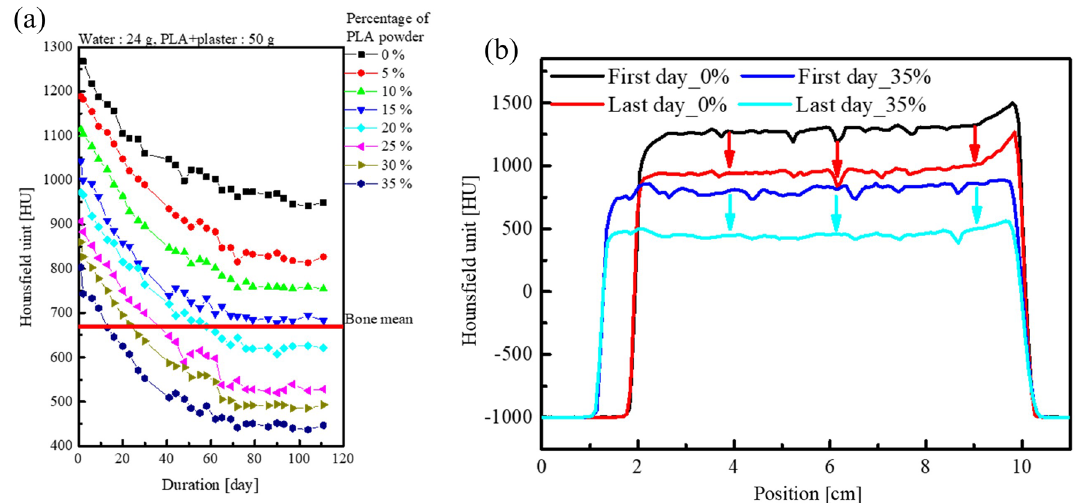
Figure 5. ( a ) Time changes in HU for the different percentage of PLA powder ( b ) HU profile of the red dotted line in Fig. 4c at 0% and